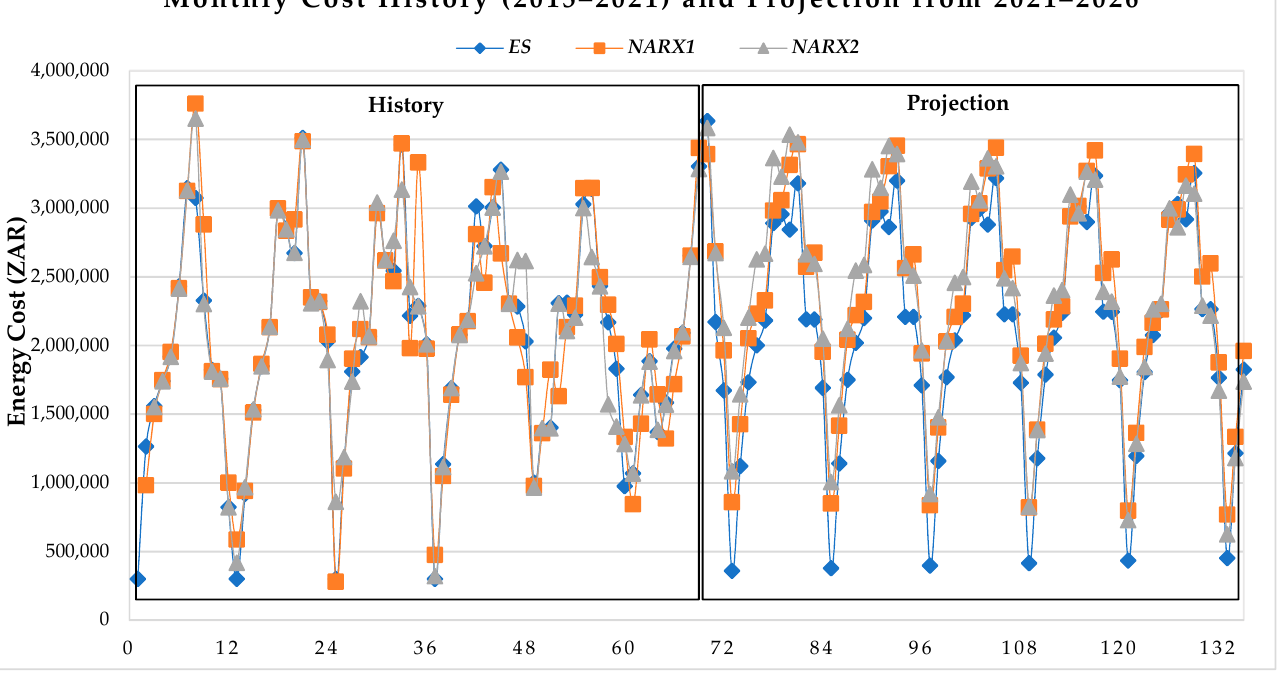
Figure 8. UJ-Res monthly energy cost history and projection over the next five years.